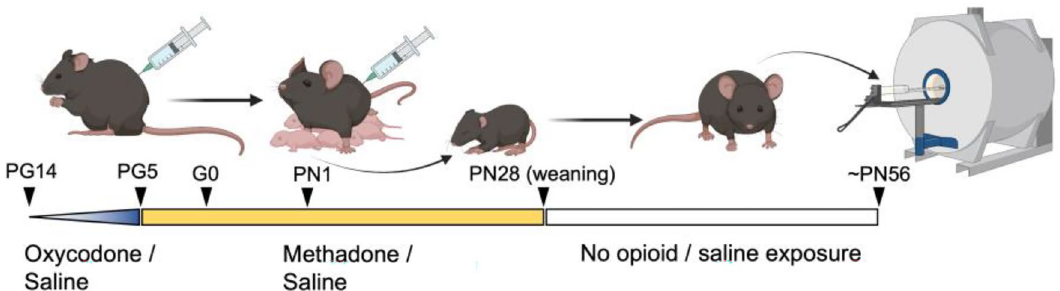
Figure 1. Diagram of experimental timeline. Adult female C57Bl/6 J mice are treated with an escalating dose of oxycodone or saline for 9 days prior to mating for pregestational (PG) exposure. Five days prior to mating (PG day 5) the female mice were switched to a maintenance dose of methadone or continued on with saline exposure. The female mice continued to receive methadone or saline from the day of mating/start of gestation (G0) throughout pregnancy. Methadone and saline were also administered to the mothers during the offspring’s postnatal period from postnatal day 1 (PN1) to PN28 upon which the offspring were weaned. Offspring received no direct administration of opioids or saline during the neonatal period or after weaning. Around 8 weeks of age, male offspring underwent